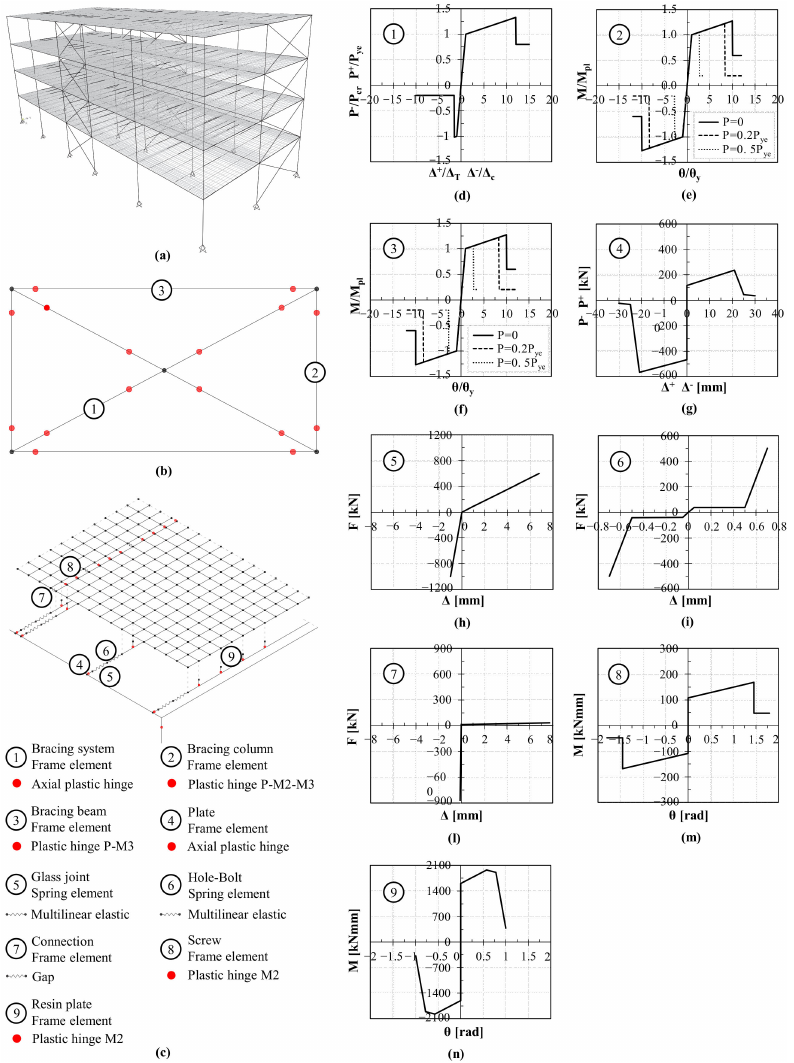
Figure 5. As-built Finite Element (FE) Model ( a ); FE subcomponents of bracing systems ( b ) and floor diaphragms ( c ); Model properties of specific FE elements: bracing system ( d ); bracing column ( e ); bracing beam ( f ); plate element ( g ); joint ( h ) ; hole-bolt element ( i ); connection frame element ( l ); screw element ( m ); resin plate element ( n